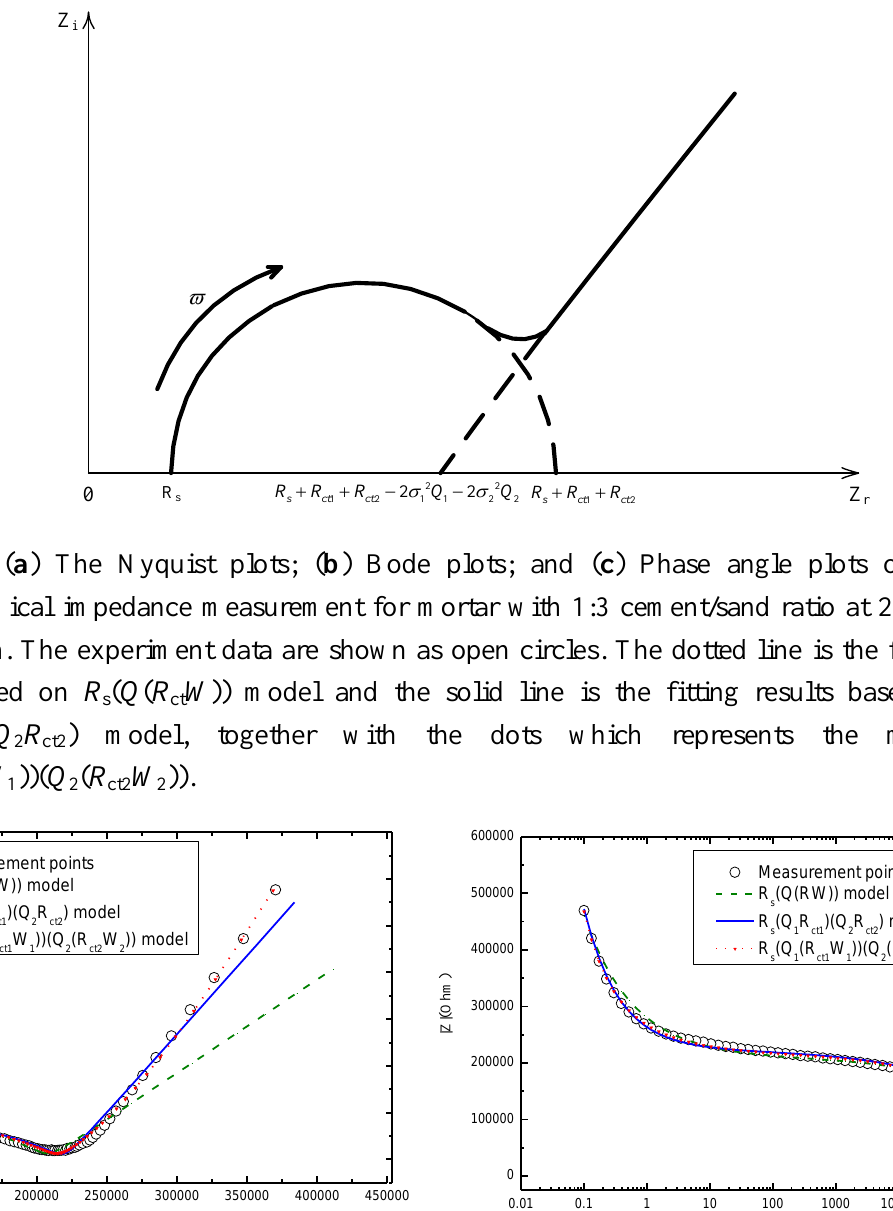
Figure 5. Curve on the complex plane corresponding to carbonation process of mortar.